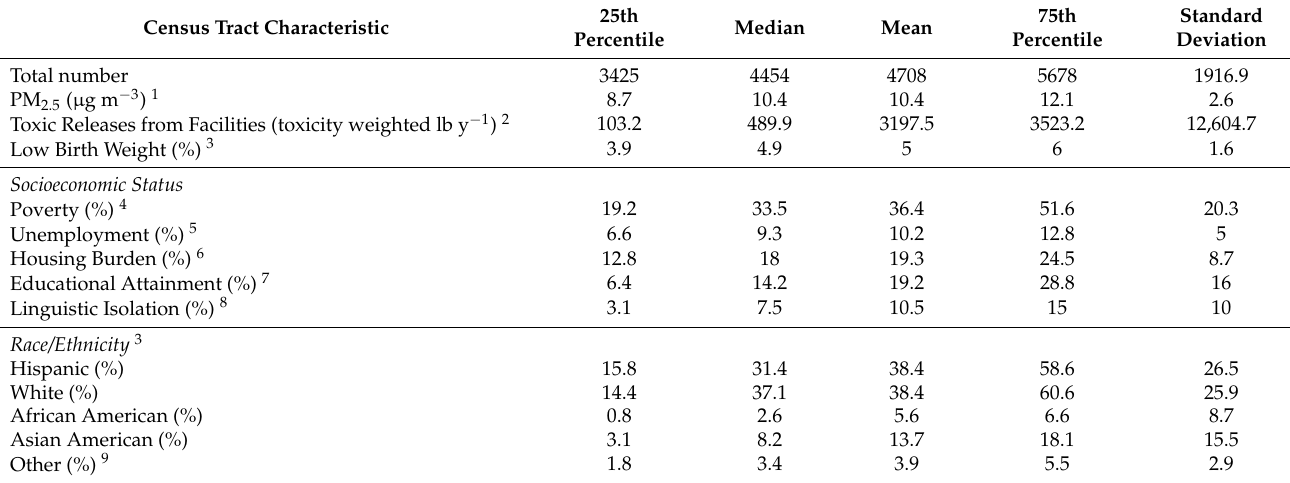
Table 1. Characteristics of 7785 census tracts in CalEnviroScreen 3.0 or 4.0. This table presents the distribution of these values from census tracts across